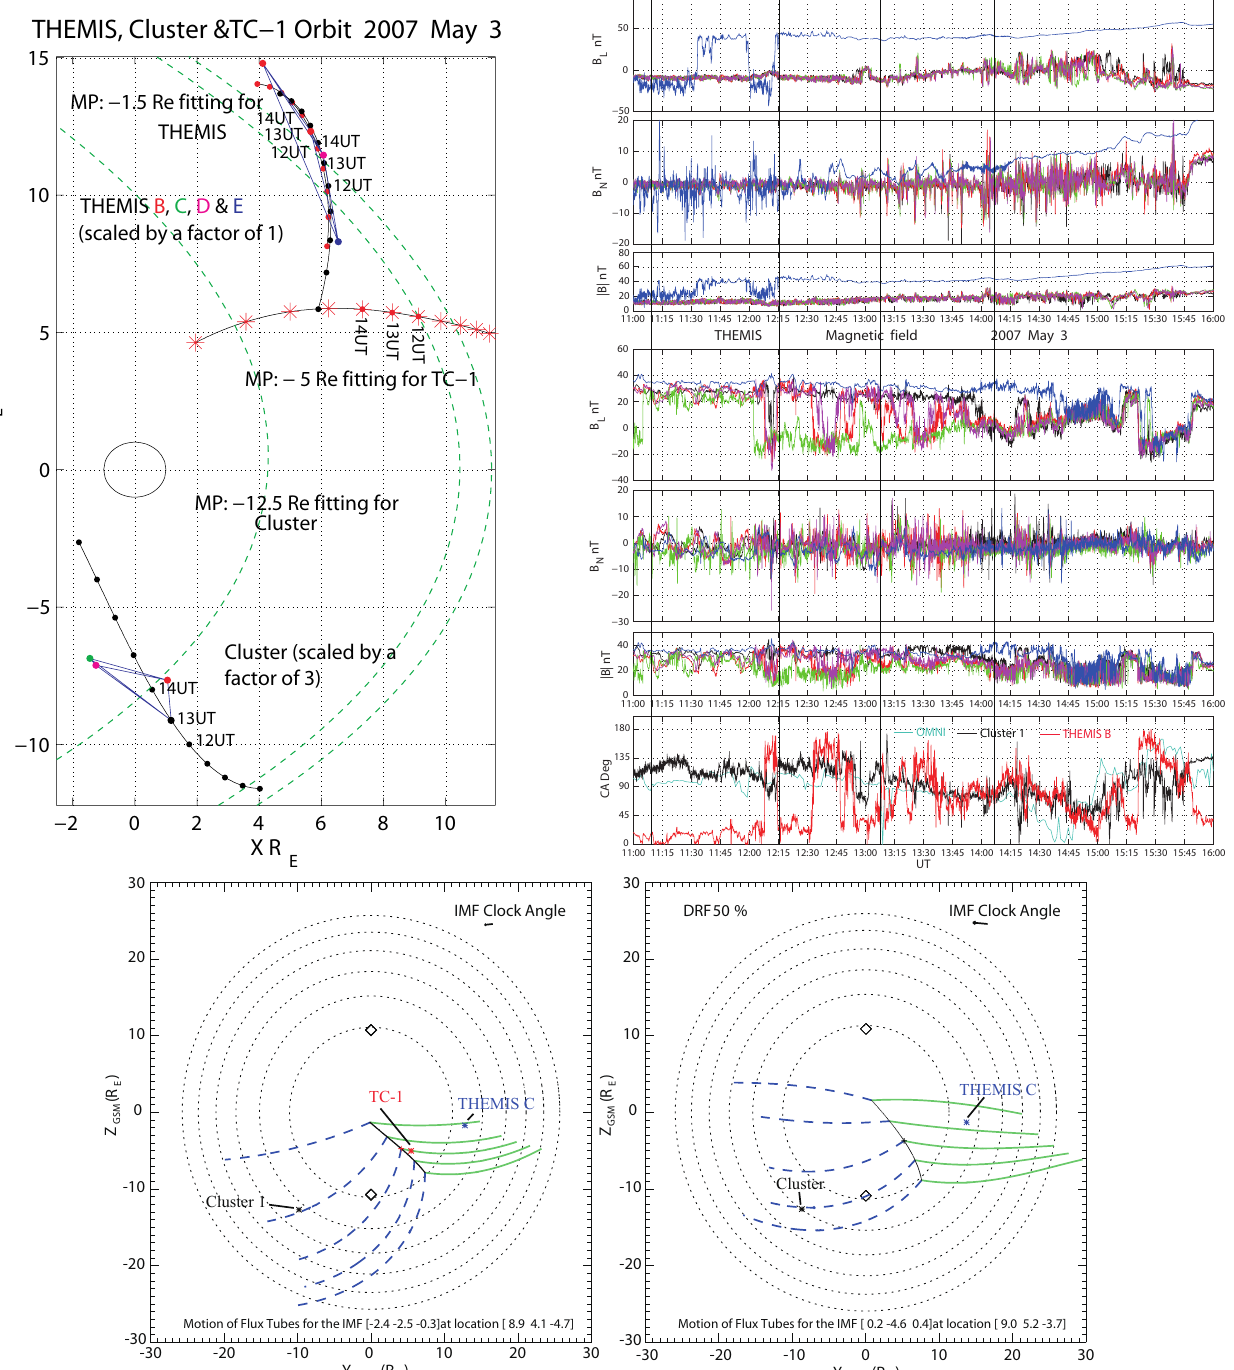
Fig. 4. A similar conjunction at the magnetopause, also reported by Fear et al. (2009), showing evidence of active reconnection in a similar format to Fig. 1: (a) summarises the ten spacecraft encounter which occurred under conditions of steady IMF − B y and steady solar wind ram pressure. The lower panel on the right hand plot shows the clock angle, calculated for Cluster 1 (in the magnetosheath until 15:50UT), THEMIS B (intermittently in the magnetosheath after 12:10UT) and the OMNI data. (b) Shows the corresponding Cooling model fit and predicted FTE motions. Also marked by stars are the positions for the Cluster, THEMIS and TC-1 spacecraft, as indicated. The fit shown on the left corresponds to the IMF direction, predominantly prevailing for the overlapping time interval where all ten spacecraft see FTE signatures (10:30–12:00UT), whereas the fit on the right corresponds to the IMF prevailing for the later interval (12:00–14:00UT), where Cluster FTE signatures mainly overlap with